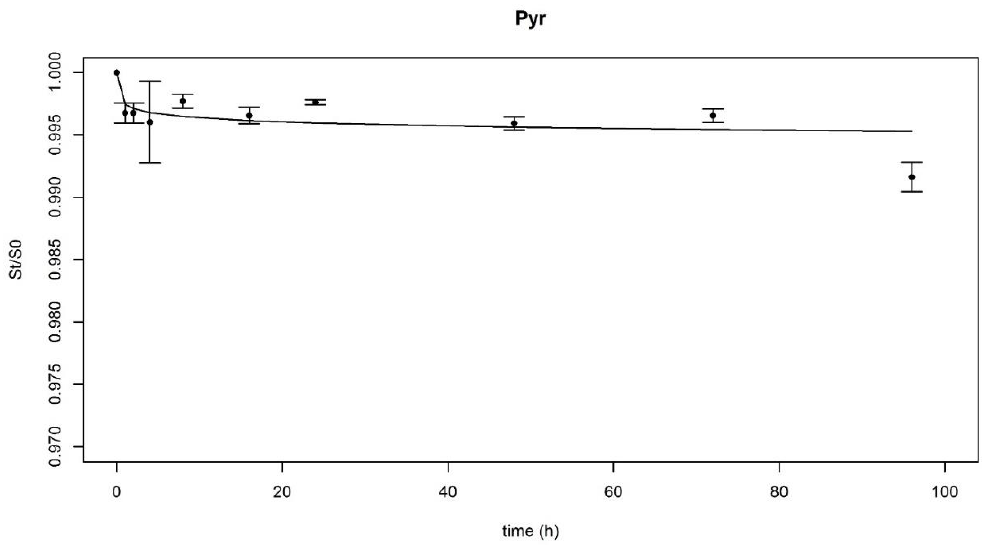
Table 3. Fitted parameters of the site distribution model for the different PAHs and t ex values calculated according to Equation (3).